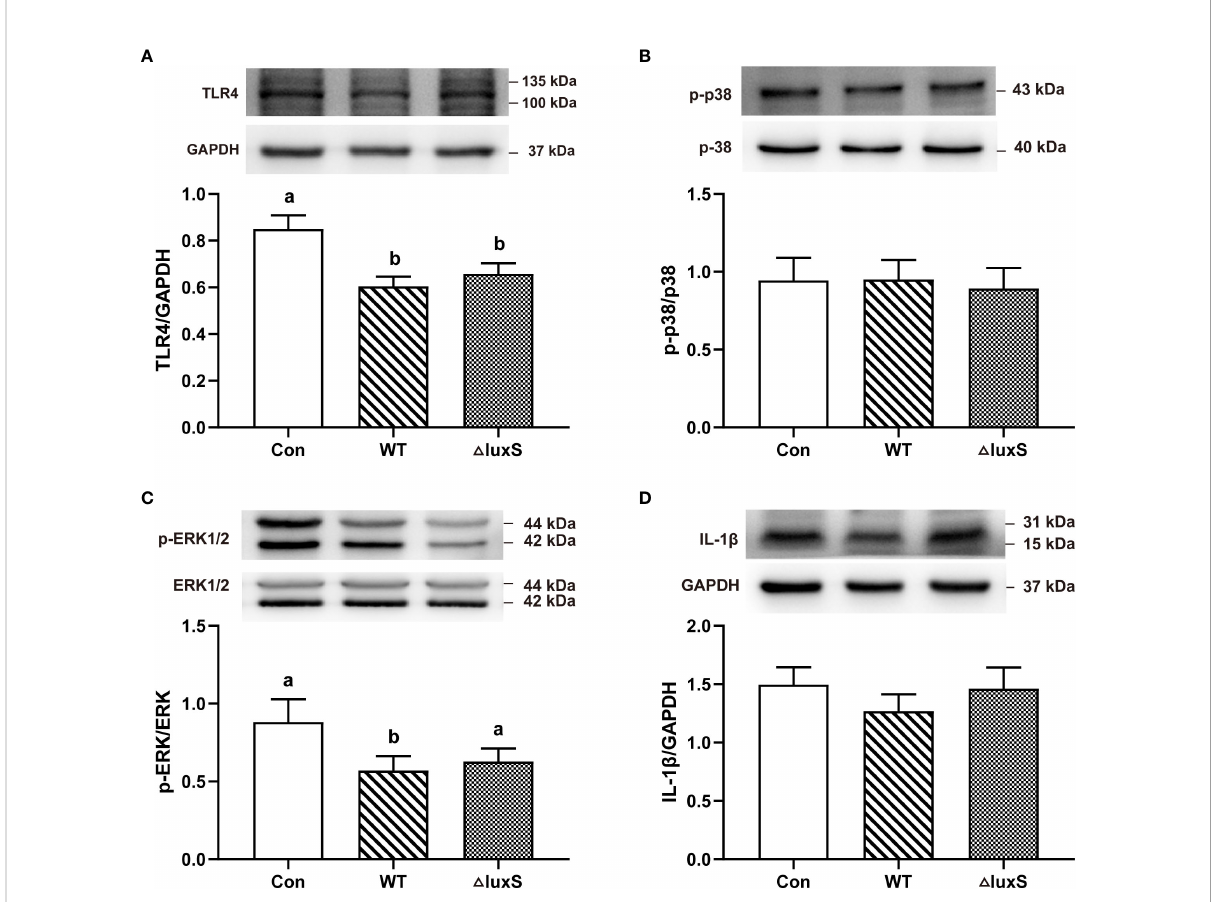
FIGURE 6 Intestinal immune functions in weaned piglets. (A-D) TLR4, p-p38, p-ERK, IL-1 b , respectively. The protein expression was quanti fi ed by densitometry and normalized to the level of GAPDH, p-38 or ERK1/2, respectively. TLR4, Toll-like receptor 4; p-, phospho-; p38, mitogen- activated protein kinase (MAPK) p38; ERK, extracellular signal-regulated kinase; IL-1 b , interleukin-1 b . WT and D luxS groups were orally inoculated with 2 mL of LGG wild strain and luxS mutant strain, respectively, for 3 weeks before weaning on day 21. Con group was orally inoculated with PBS. Statistical signi fi cance performed using one-way analysis of variance for multiple comparisons. Mean values not sharing common letters are signi fi cantly different ( P <0.05). Values are shown as mean ± SEM,